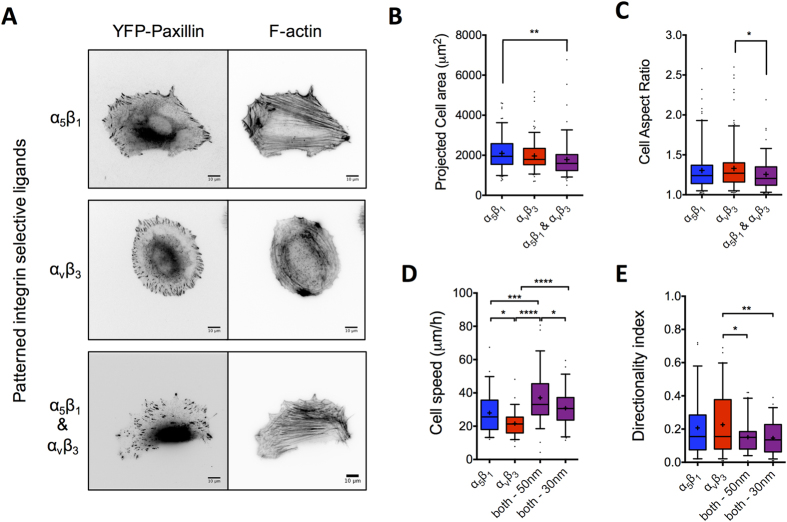
Immobilized α5β1 and αvβ3 integrin selective ligands on patterned substrates do not promote high directional persistence in fibroblast migration.(A) REFYFP-PAX actin cytoskeleton and YFP-paxillin clustering 6 hours post-seeding on patterned gold particles with a 50 nm average inter-particle distance, and functionalized with the indicated ligands. Stress fiber morphology on α5β1- and αvβ3-selective surfaces resembles that on FN and VN, respectively. FAs, but not NAs nor polarized protrusions, are present on patterned substrates, independent of the type of immobilized ligands. (B,C) Quantification of REFWT projected cell area (B) and aspect ratio (C) 6 hours post-seeding on patterned gold particles with a 50 nm average inter-particle distance (n > 100 cells). (D) Cell speed increased on patterned substrates with a 50 nm inter-particle distance presenting both α5β1- and αvβ3-selective ligands (1:1 ratio) compared to substrates presenting these ligands alone (n = 60 cells from Nexp = 3). Decreasing the inter-particle distance to 30 nm resulted in a slight decrease in cell speed when both ligands were present (n = 60 cells from Nexp = 2). (E) DI remained very low for REFWT on all substrates, independent of integrin ligand type or density, indicating random migration on patterned substrates. The middle line in box plots indicates the median, the box indicates the interquartile range, the whiskers the 5th and 95th percentiles and the cross the mean. Experimental data were compared using one-way ANOVA with Tukey’s post-test analysis. Only statistically significant differences are shown: *P < 0.05; **P < 0.01, ***P < 0.001, ****P < 0.0001. Scale bars: 10 μm.